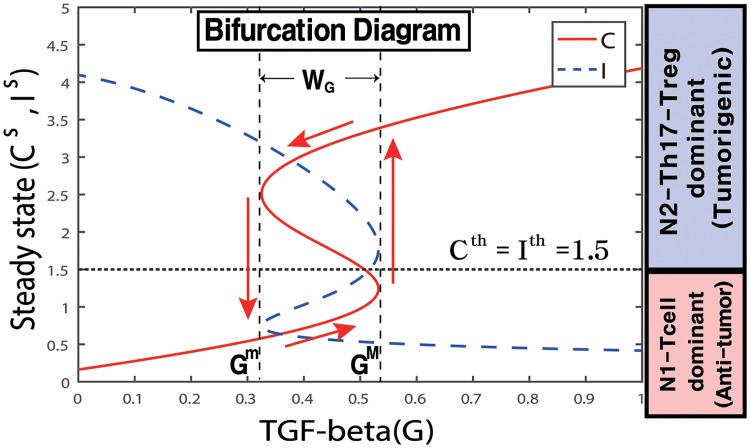
Bifurcation diagram.High and low TGF-β signals (G) provide an on-off switch of N2 activation and determine the dichotomous behavior: cancer cell activation and benign status. Y-axis = steady state (SS) of levels of the N2 (C) and N1 (I) complex modules. WG = [Gm, GM] = a window of bi-stabilty. S = 0.2. Other parameters are given in Table 2.